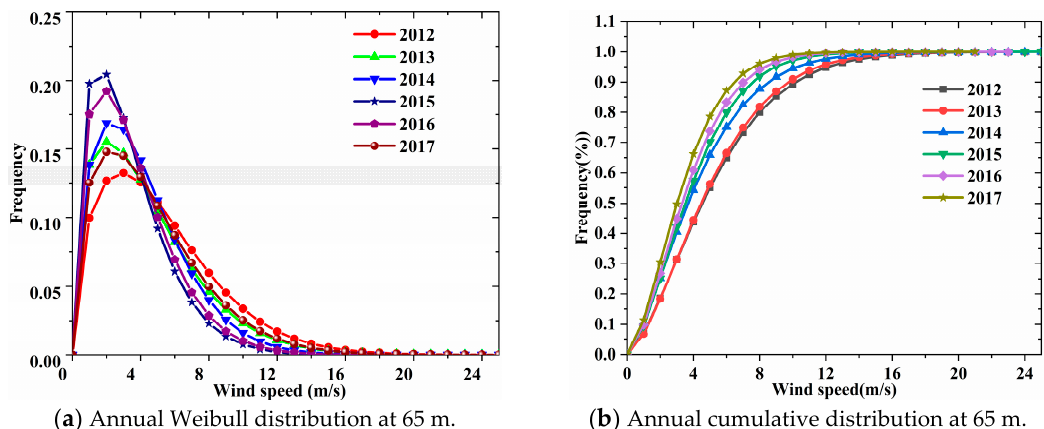
Figure 4. Monthly mean wind speed for 10 m and 65 m from 2012 to 2017.